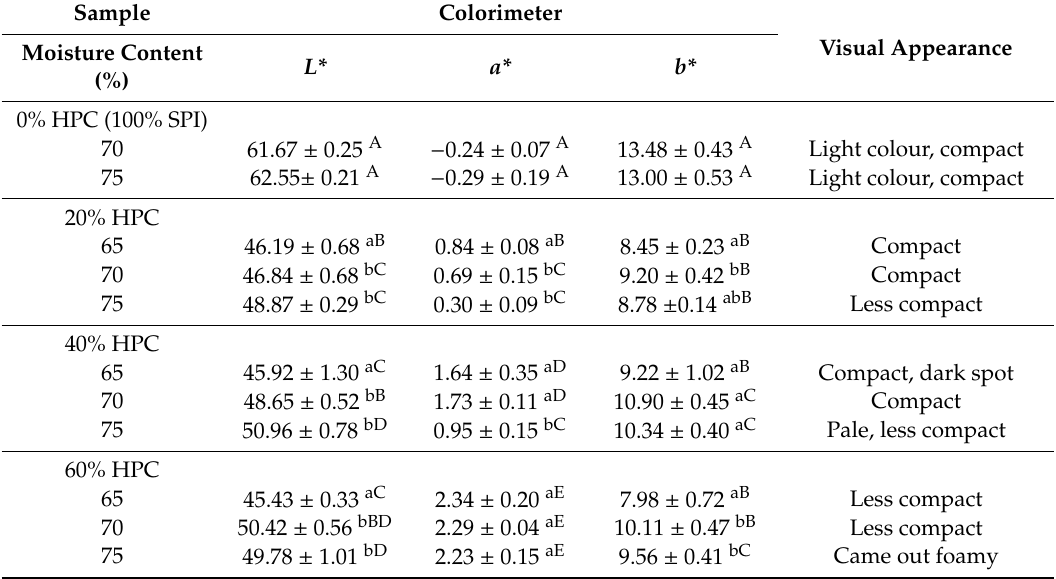
Table 4. Result of L* , a* and b* using colorimeter with a short description of each product 1 . Sample